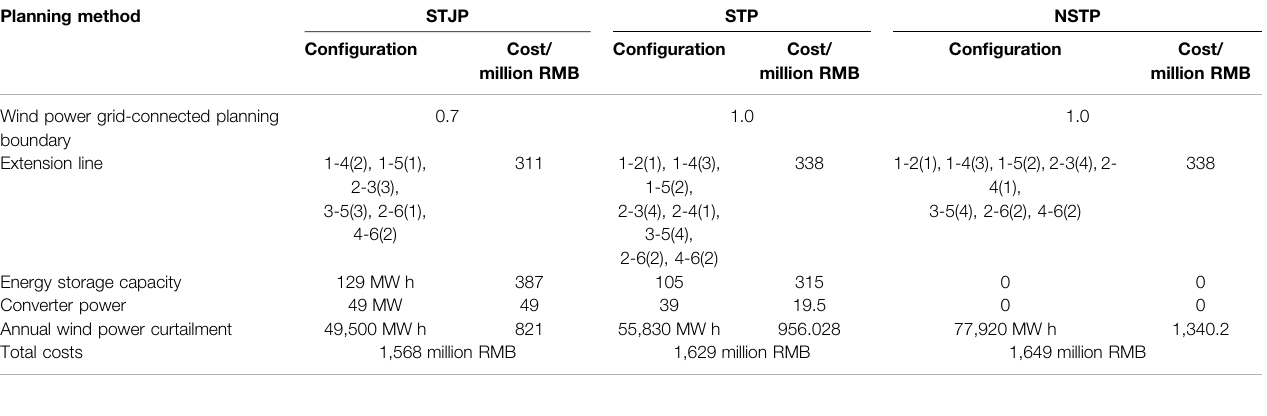
TABLE 4 | Different planning methods of Garver6 system.